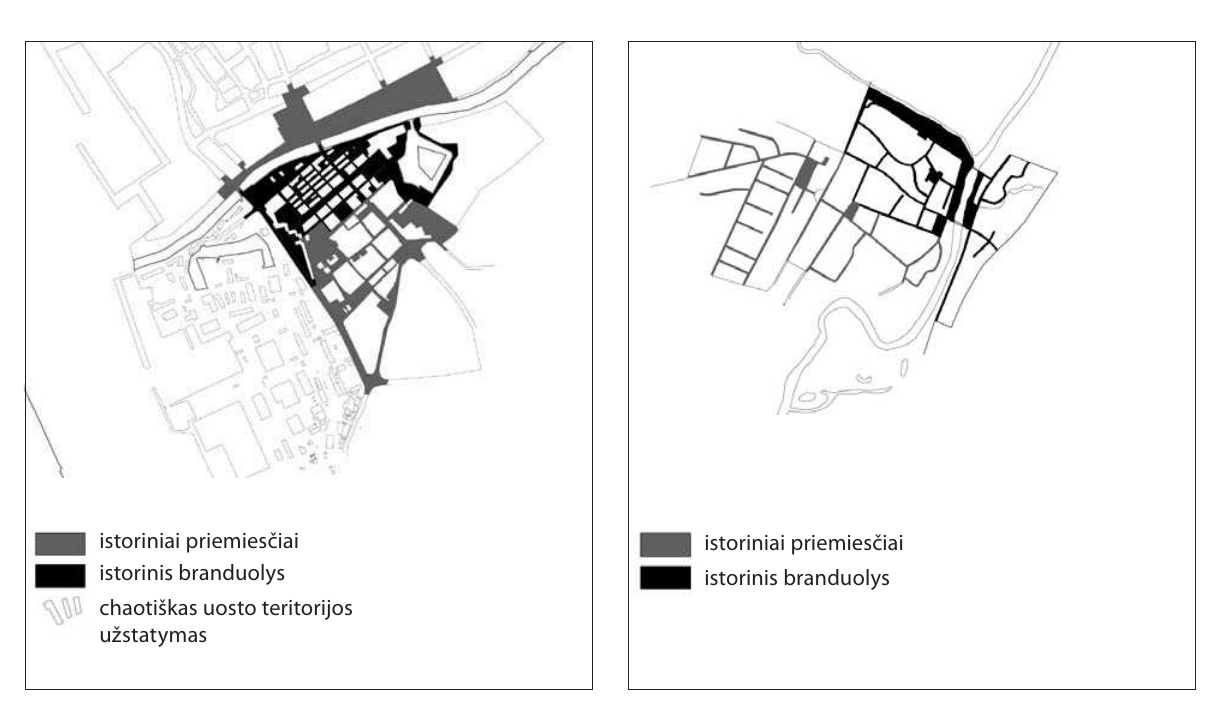
Figs. 2 . network of streets and squares of old